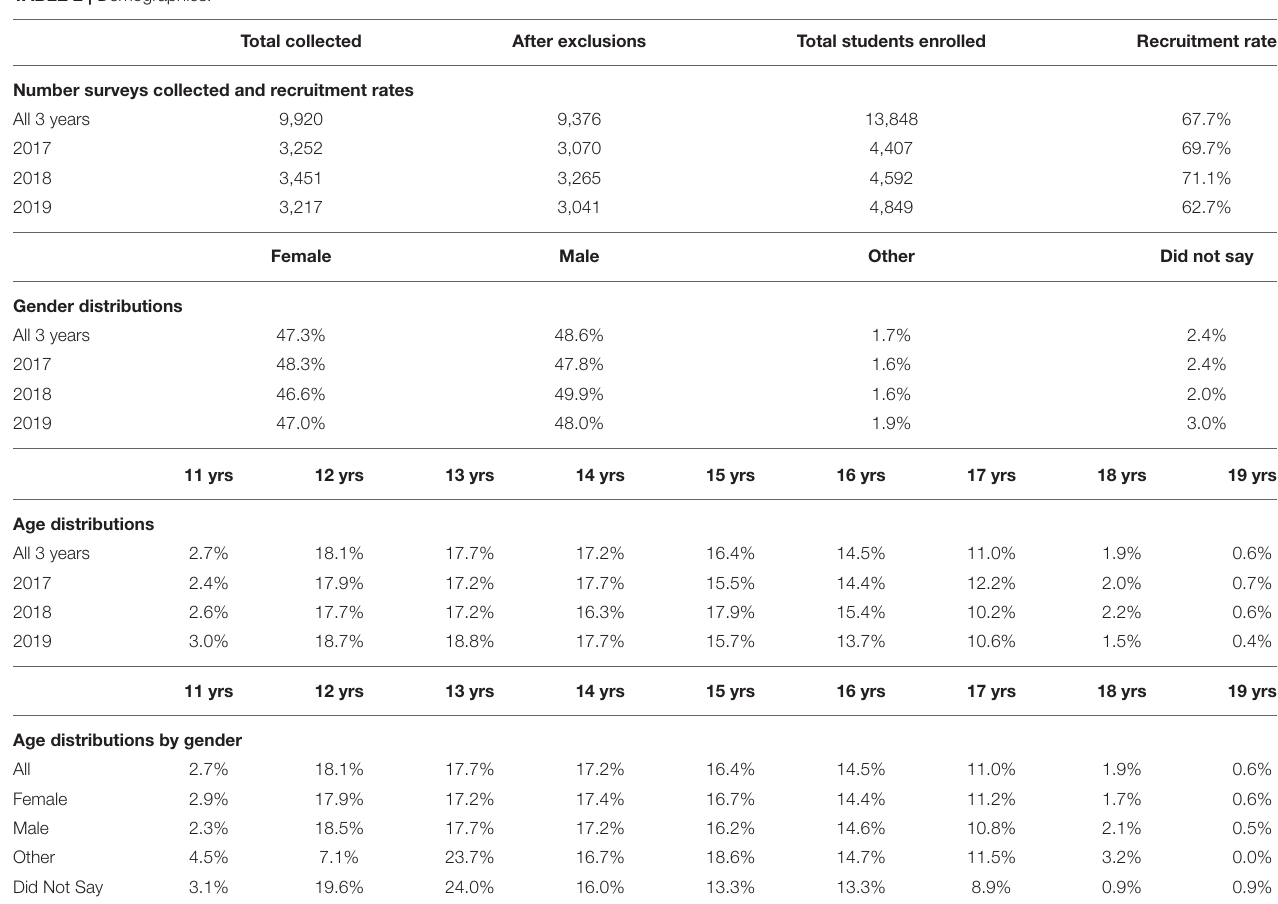
TABLE 2 | Demographics.